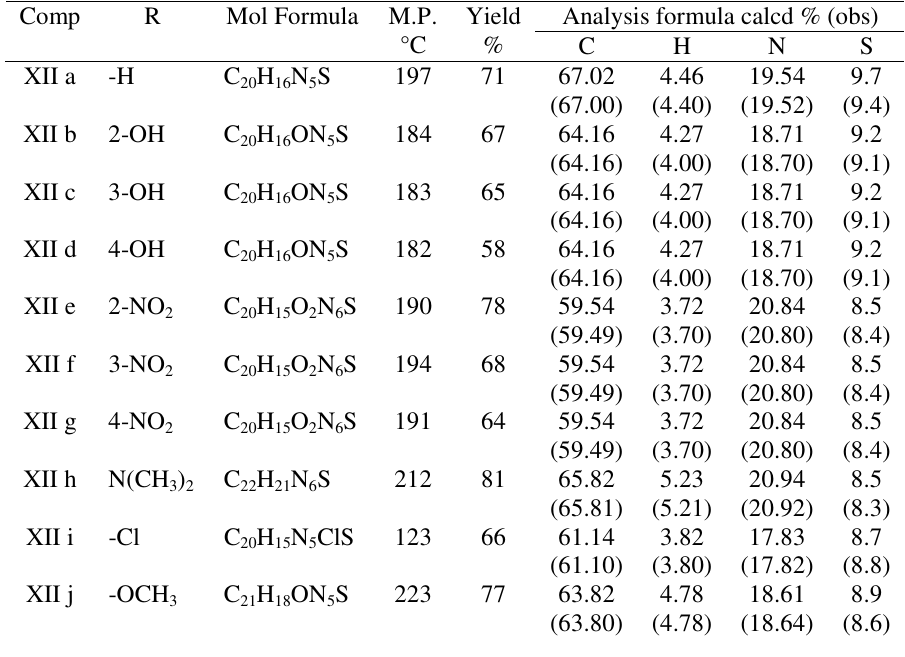
Table 3. Characterization data of newly synthesized compounds (XII